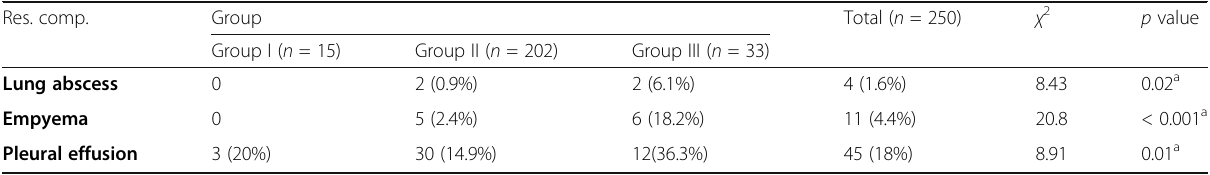
Table 4 Distribution of respiratory complications among all studied groups Res.